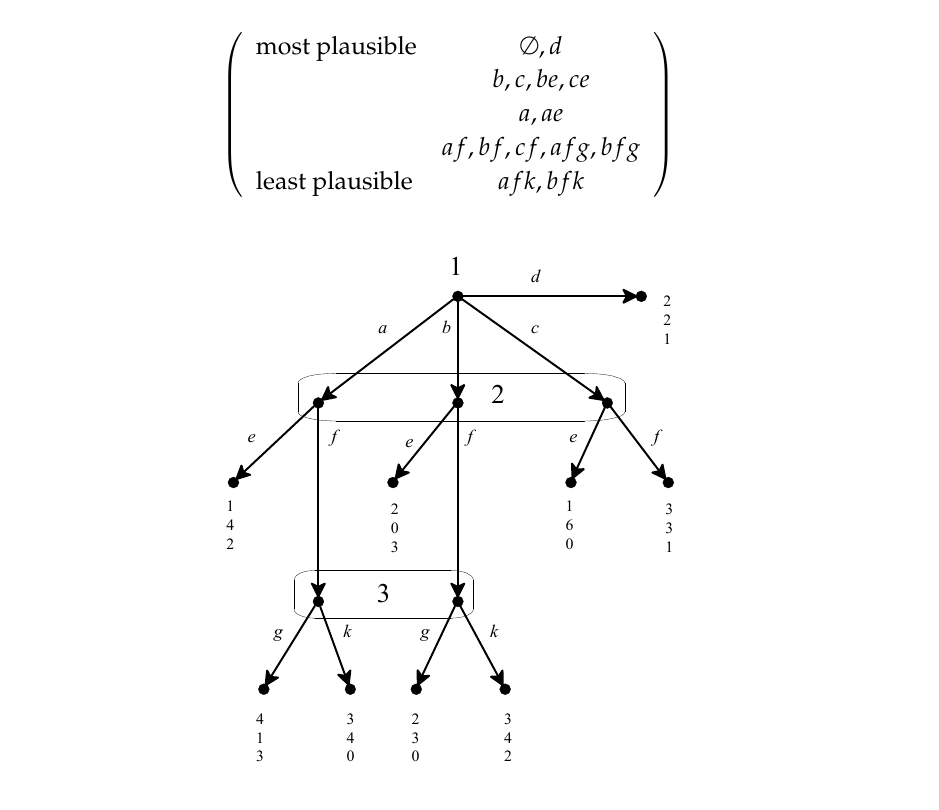
Figure 1. An extensive-form